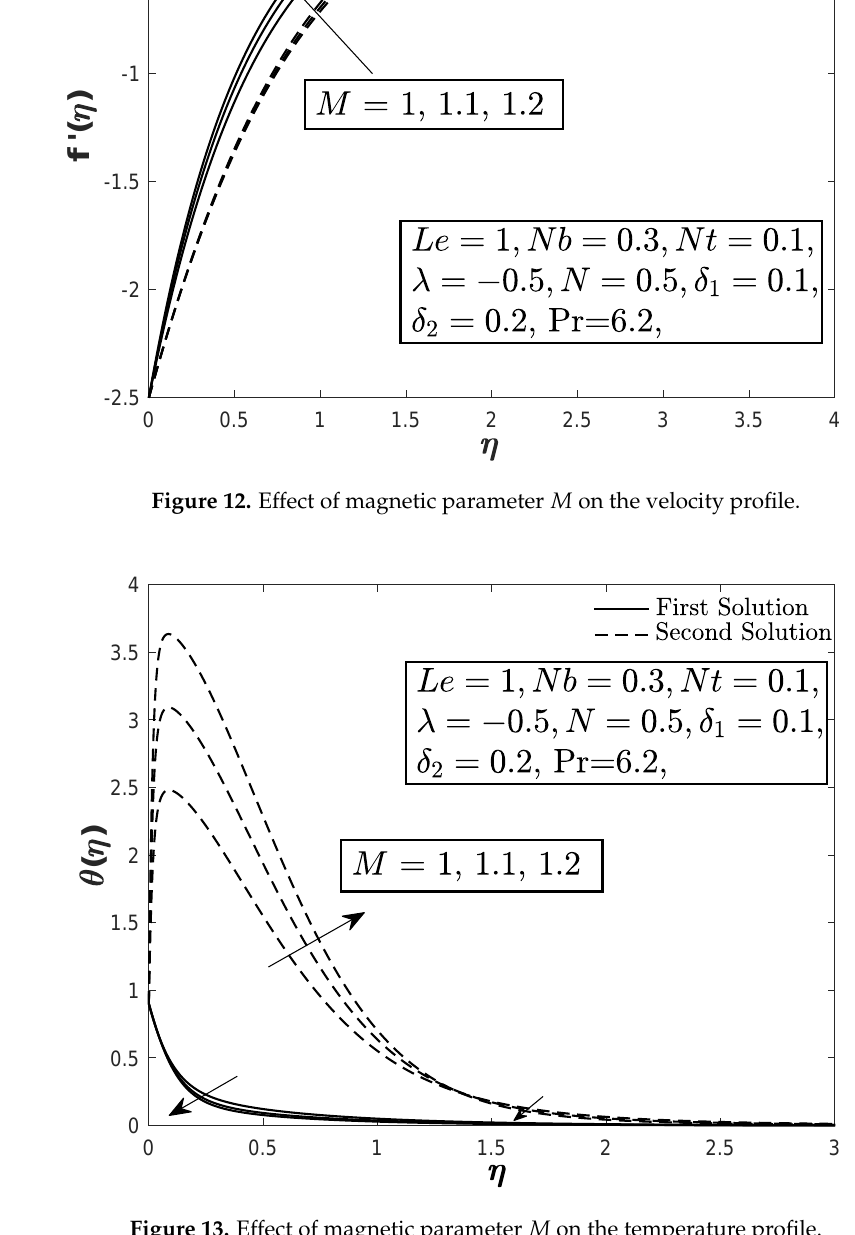
Figure 13. Effect of magnetic parameter M on the temperature